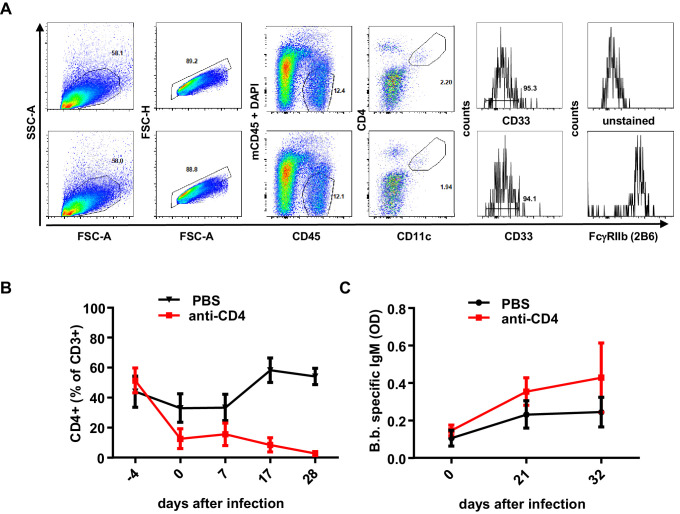
FcγRIIb expression on dendritic cells and effect of human T cells on B. burgdorferi specific immune responses.(A) Shown is a representative example of a FACS analysis detecting FcγRIIb expression on human dendritic cells in the spleen of humanized mice using CD45, CD33, CD11c, CD4, and FcγRIIb (using the 2B6 antibody clone) as markers. To distinguish FcγRIIb staining from background fluorescence the sample was split and stained with all the indicated markers with the exception of FcγRIIb staining (marked as unstained in the upper panel). (B) Depicted is the percentage (mean+/-SEM) of human CD4+ T cells within human CD3+ cells in the peripheral blood of humanized mice continuously treated with a CD4-specific antibody. n = 6 mice per group. (C) Shown is the B. burgdorferi-specific antibody IgM response (mean+/-SEM) in humanized mice treated with PBS or a CD4-specific antibody as determined by ELISA. n = 6 mice per group.